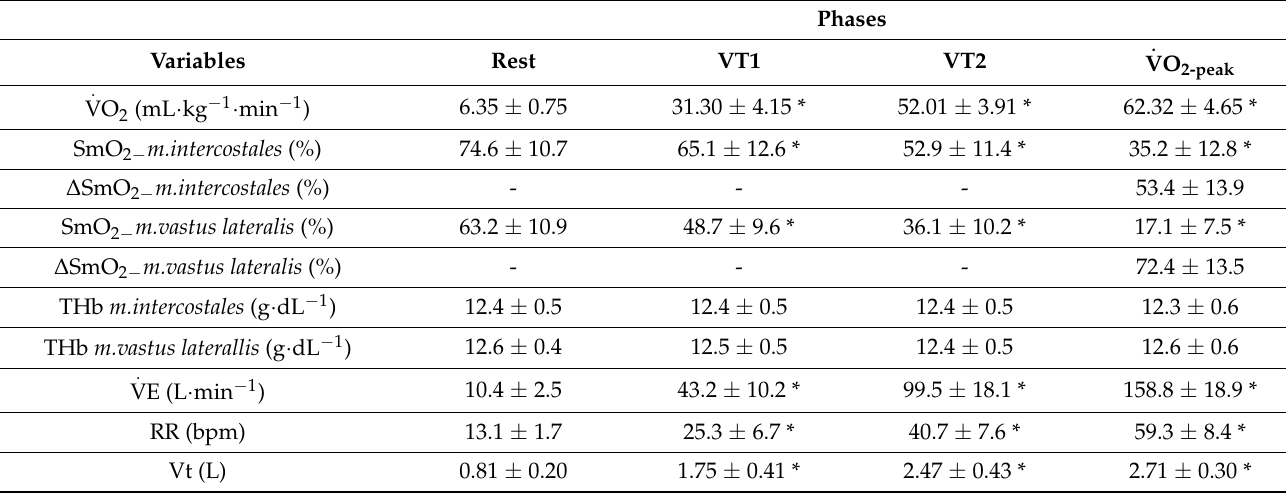
Table 1. Oxygen consumption, muscle oxygen saturation, total hemoglobin and ventilatory variables in the different phases of exercise (n =